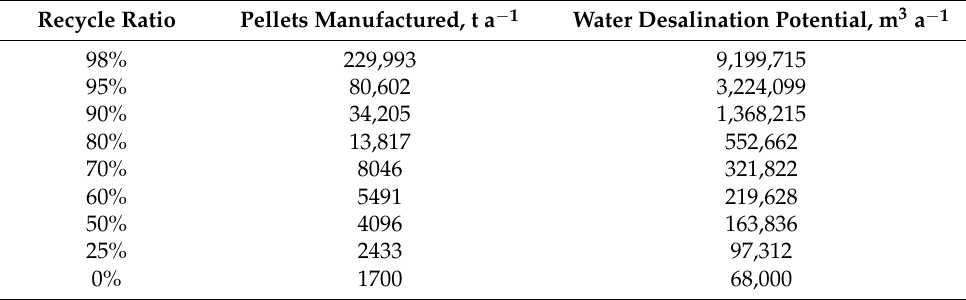
Table 5. Expected Pellets manufactured and desalination water potential of the manufactured pellets. Assumptions: A proportion of the product gas is recycled to the ZVI Reactor; Manufactured volumes are based on a feed gas flow rate of 14 m 3 m − 1 (Table